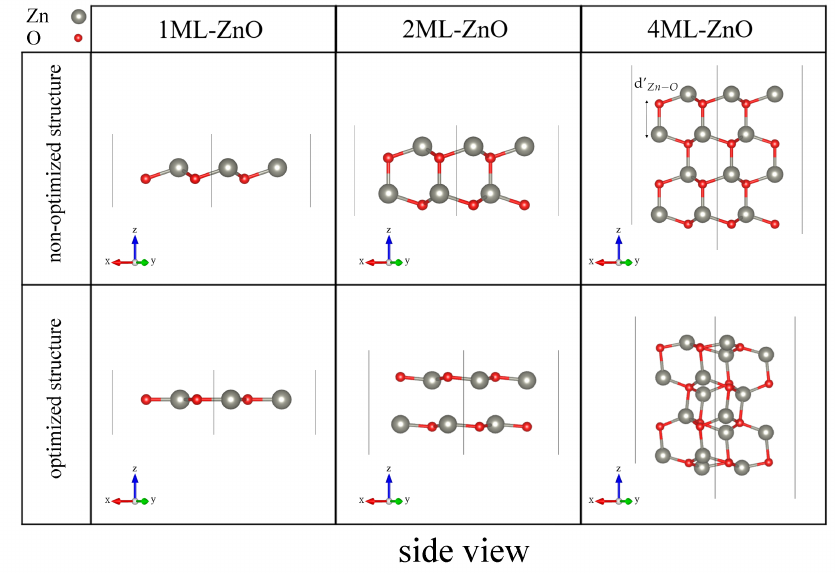
Figure 2. Schematic representation of non-distorted and equilibrium atomic structure of layered ZnO substrates. The definition of wurtzute-like Zn–O interlayer bond length d’ Zn − O is based on prescriptions given by Tusche et al. [44].